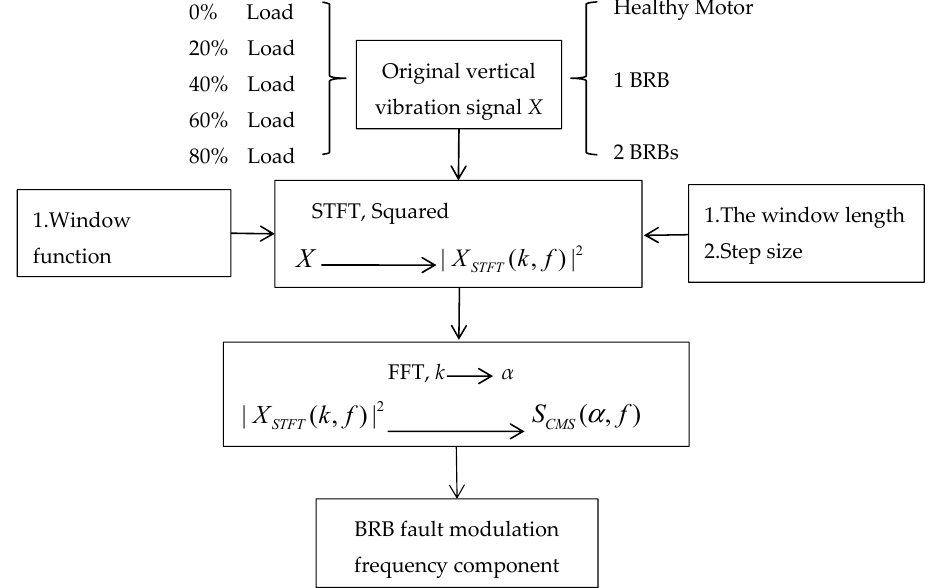
Figure 1. Flowchart of the proposed